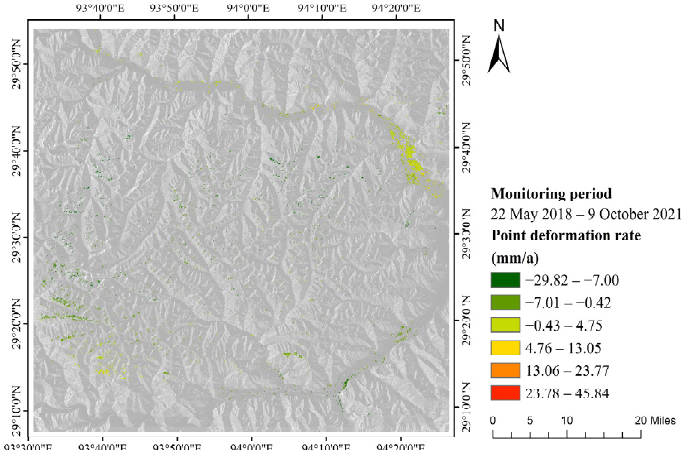
Figure 4. PS-InSAR surface point deformation rate diagram.